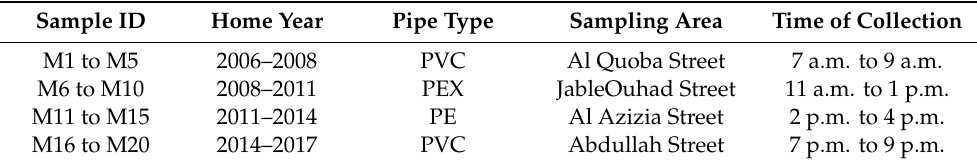
Table 2. Sample IDs, home year, pipe types, sampling area, and time of samples collection from Medina Al-Munawarah city.